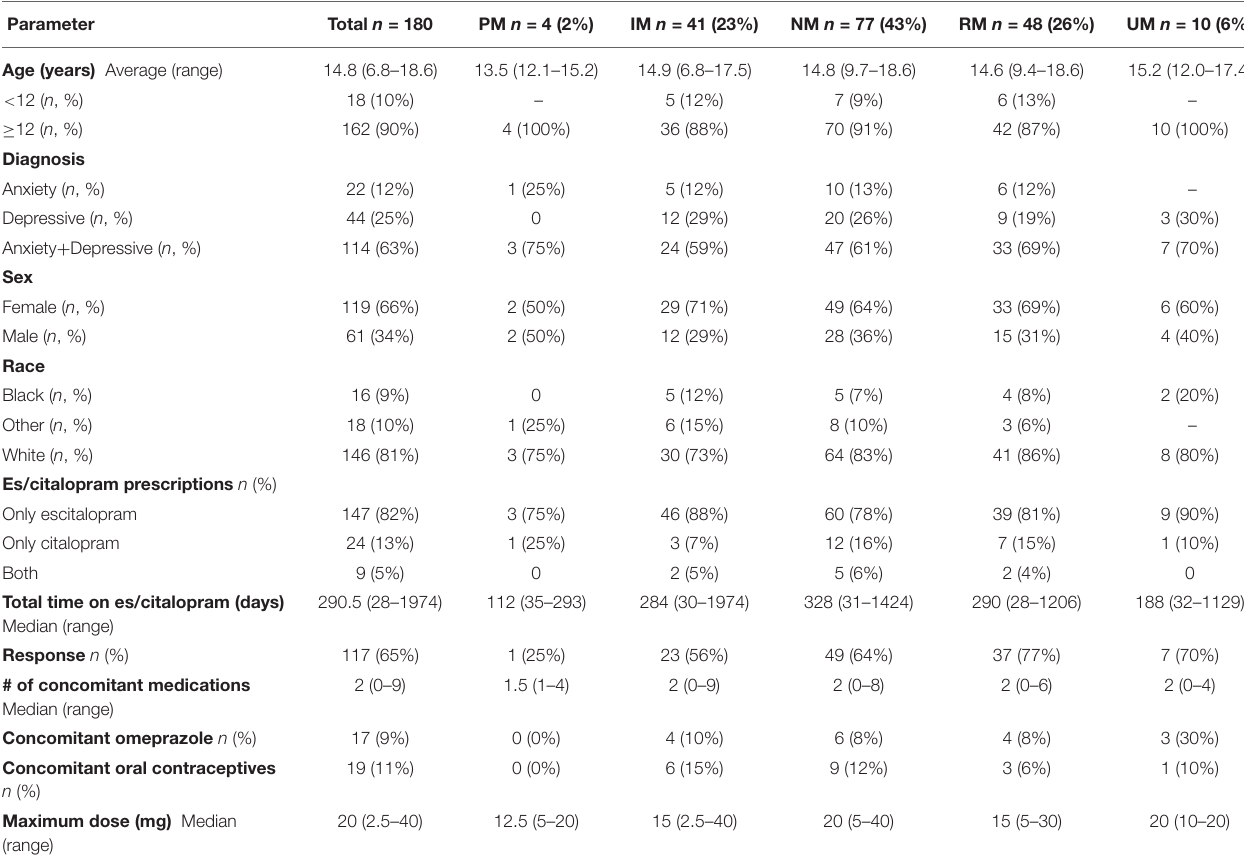
TABLE 2 | Demographic and prescription data of response cohort by CYP2C19 phenotype. Parameter